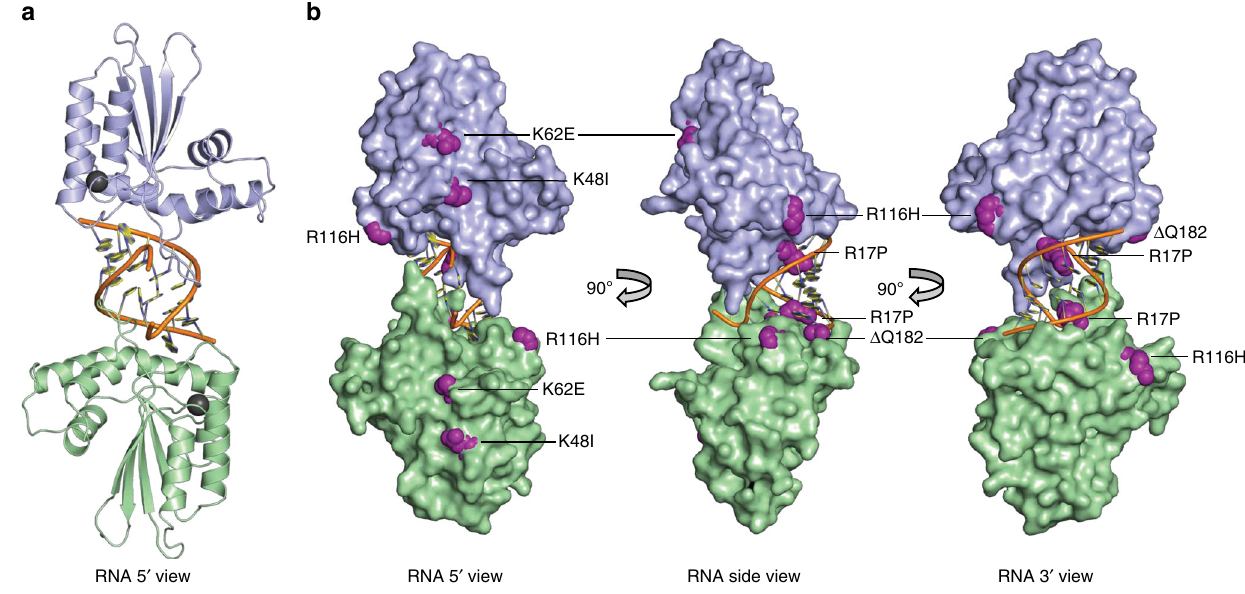
Fig. 3 Crystal structure of pgtA3H ζ -RNA complex. a Two A3H molecules (blue and green cartoon, Zn as gray sphere) at the ends of a central RNA duplex (orange backbone, yellow bases). b Sites of pgtA3H polymorphic variation. The A3H surface (colored as in A) with sites of variation in magenta. The RNA is nearly engulfed by the two A3H molecules, which have no direct contacts with each